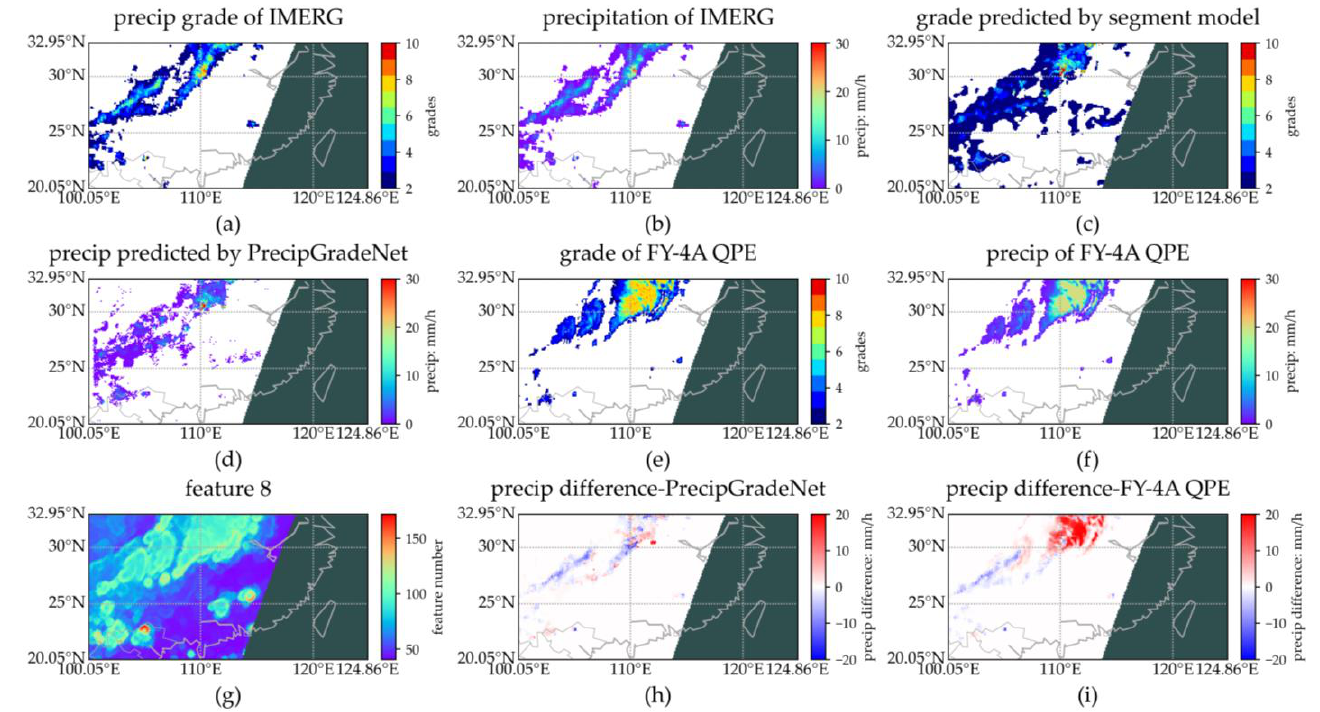
Figure 11. Comparison of precipitation grade and precipitation of IMERG, PrecipGradeNet, and FY-4A L2 QPE during 2021-09-19T02:45:00 UTC (( a ) precipitation grade of IMERG; ( b ) precipitation of IMERG; ( c ) grade predicted by segment model of PrecipGradeNet; ( d ) precipitation predicted by PrecipGradeNet; ( e ) precipitation grade of FY-4A L2 QPE; ( f ) precipitation of FY-4A L2 QPE; ( g ) the feature 8 brightness temperature different; ( h ) precipitation difference between PrecipGradeNet estimation and IMERG; ( i ) precipitation difference between FY-4A L2 QPE and IMERG).